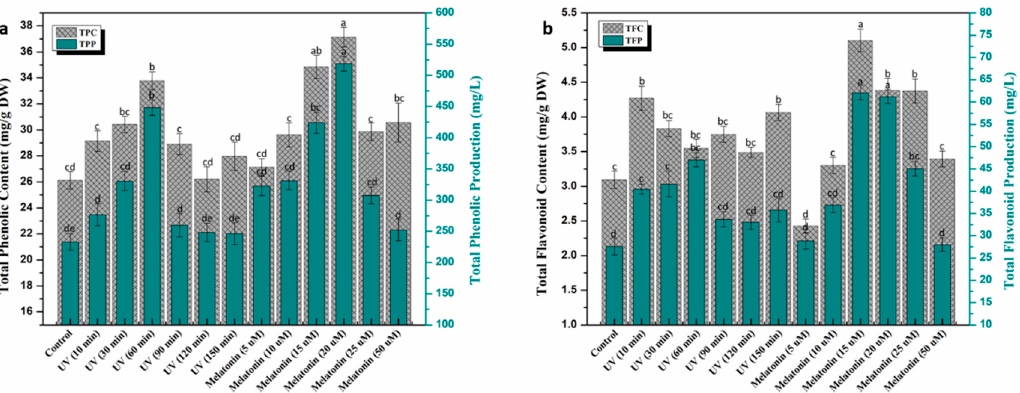
Figure 3. Effect of UV-C radiation and melatonin on ( a ) Total phenolic content (TPC, mg/g DW) and 152 total phenolic production (TPP, mg/L), ( b ) Total flavonoid content (TFC, mg/g DW) and total flavonoid production (TFP, mg/L) in callus culture of L. sativum. Values represent means ± standard errors from triplicates. Columns with similar alphabets (letters a–e) are not significantly different ( p < 0.05). 156